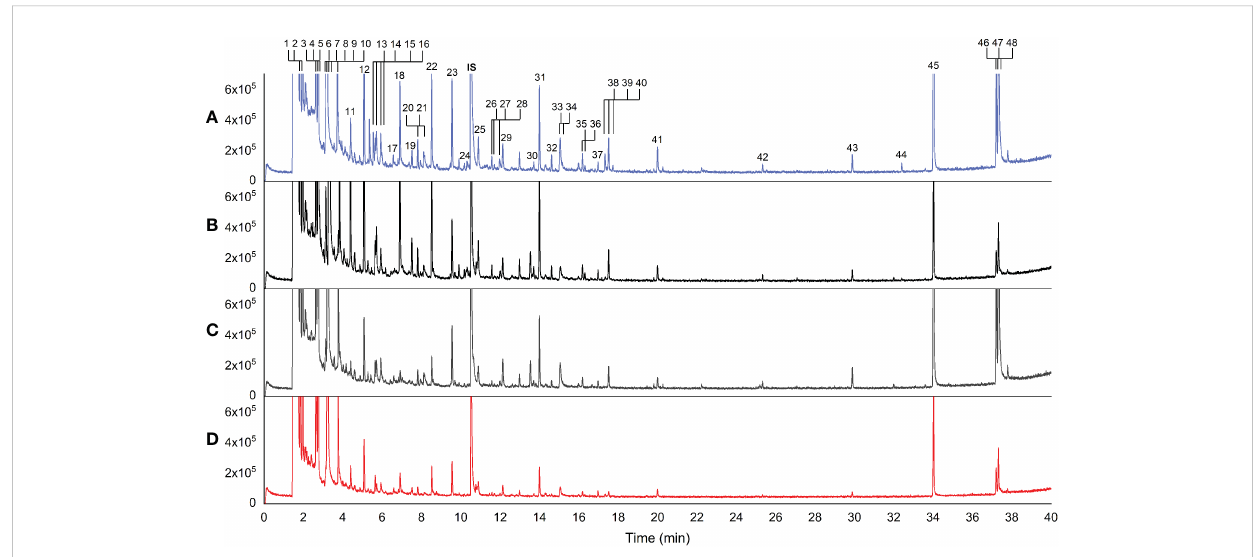
FIGURE 1 Representative chromatograms of rice volatile compounds detected by static headspace gas chromatography – mass spectrometry method. (A) aromatic white rice (Basmati 370), (B) aromatic black rice (Klamhom), (C) non-aromatic black rice (Riceberry), (D) non-aromatic red rice (RD 69 Tubtim Chumphae); IS = internal standard. Each number represented the identi fi ed volatile compounds arranged by retention